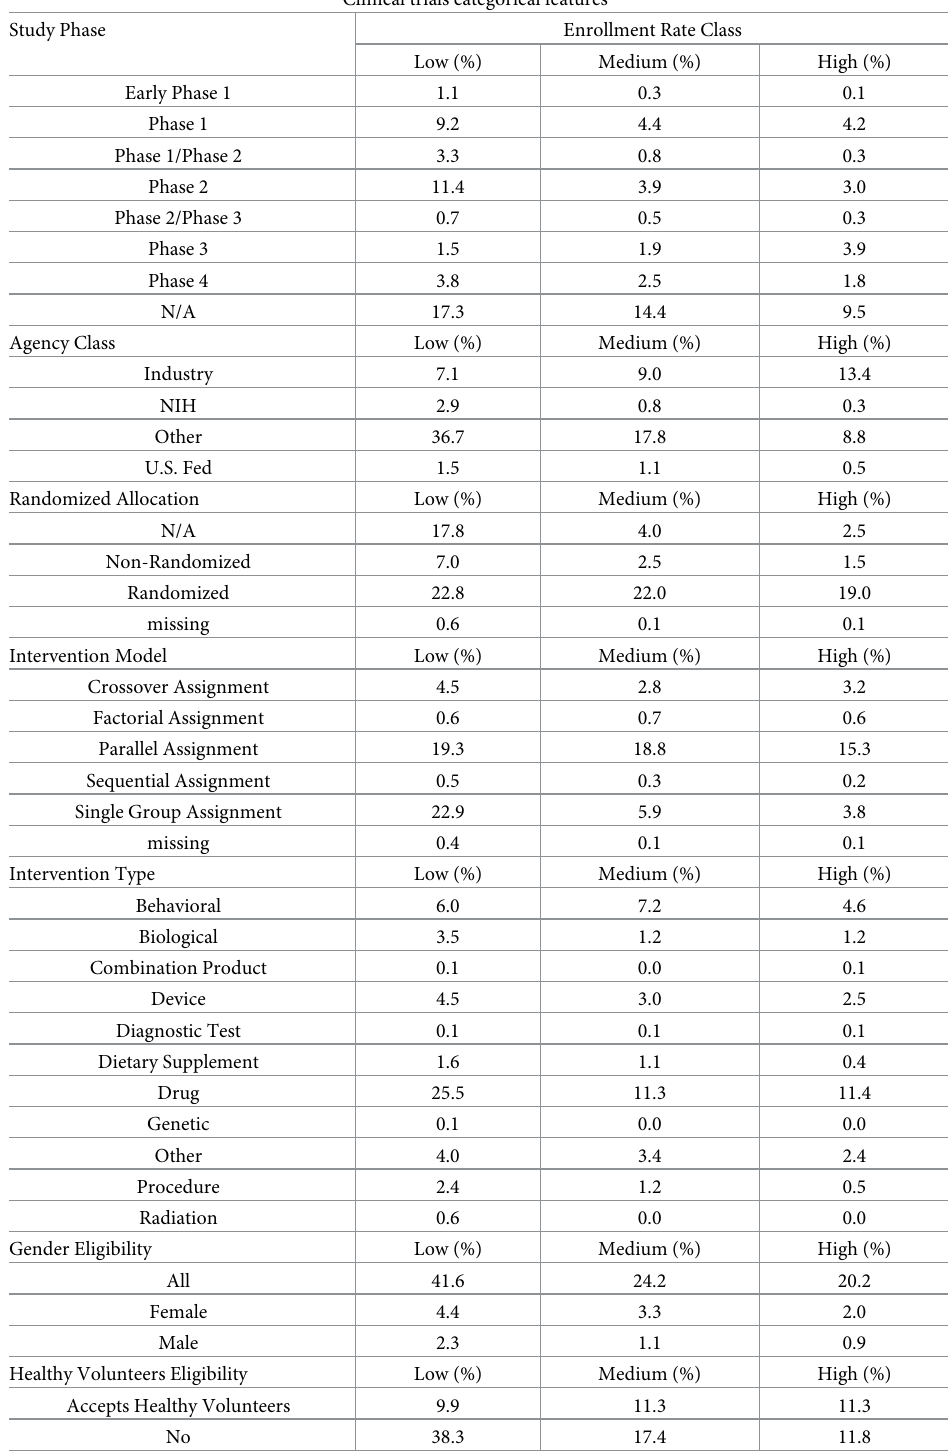
Table 1. Characteristics of the clinical trials. Summary statistics (percentage for categorical variables, median with interquartile range for continuous variables) of features in each enrollment rate categories were shown. “missing” level represents missing value. Only the top 5 most prevalent MeSH terms were